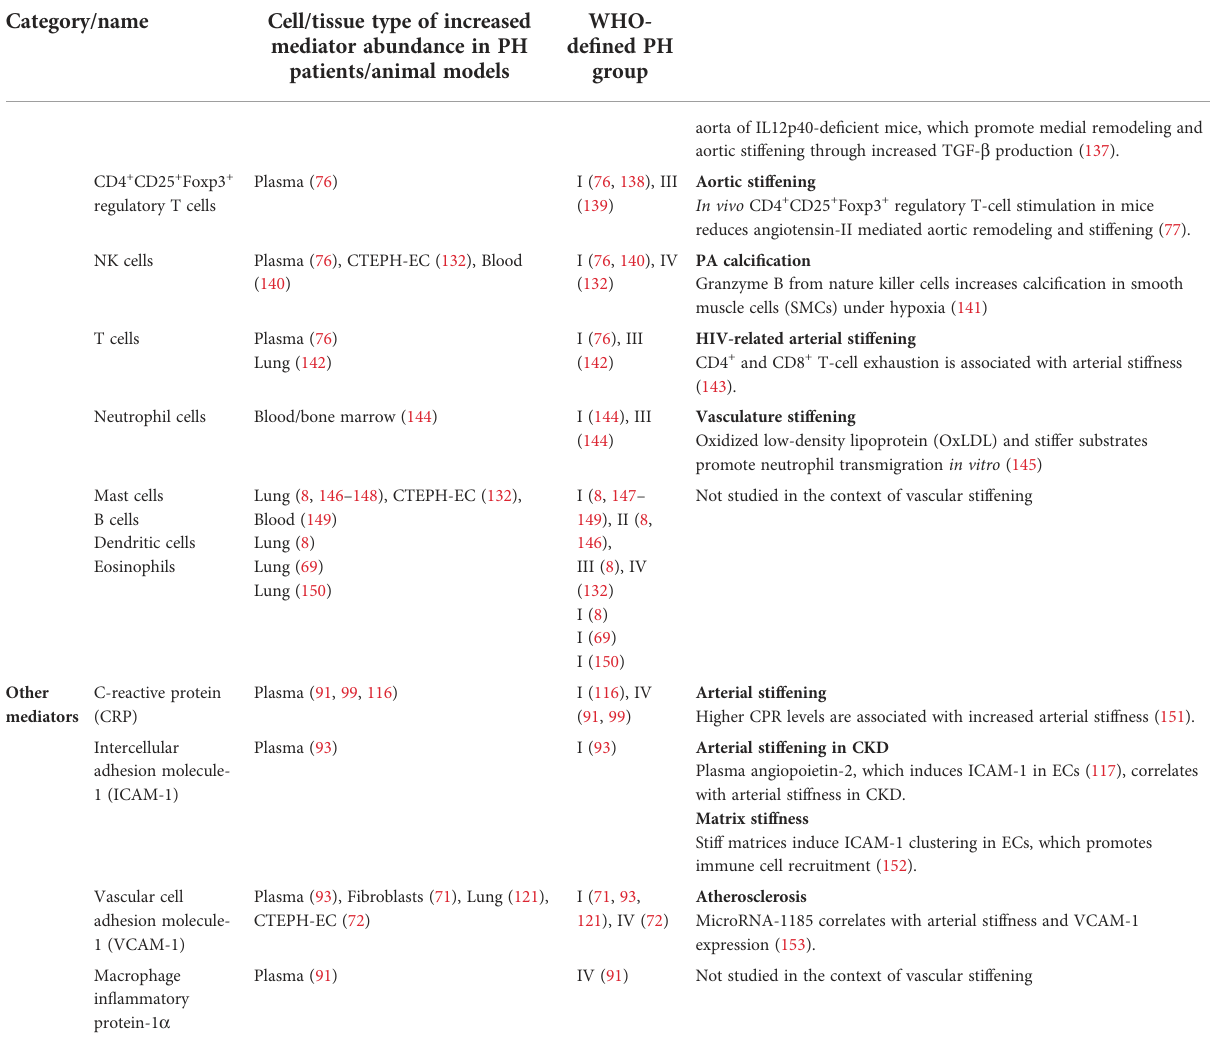
migration of SMCs into precapillary arterioles (60, 61, 81) (Table 2; Figure 2), potentially affecting arterial compliance by increased wall thickening. In the pulmonary adventitia, fi broblasts activate recruited macrophages through paracrine IL-6 signaling, initiating a pro-in fl ammatory and pro- fi brotic phenotype that is associated with an increased in fl ammatory response and vascular remodeling in PH (7). Notably, IL-6 is a sensitive marker for systemic in fl ammation in